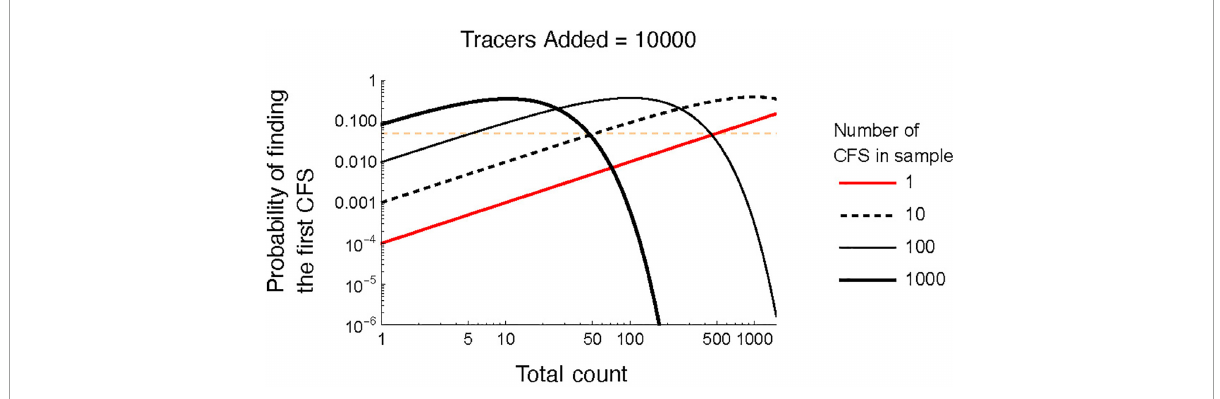
FIGURE4 Probability of finding the first coprophilous (dung-inhabiting) fungal spore (CFS) as total count increases. Each line denotes an increasing ratio of CFS to tracers. The horizontal red line shows a probability of 0.05.